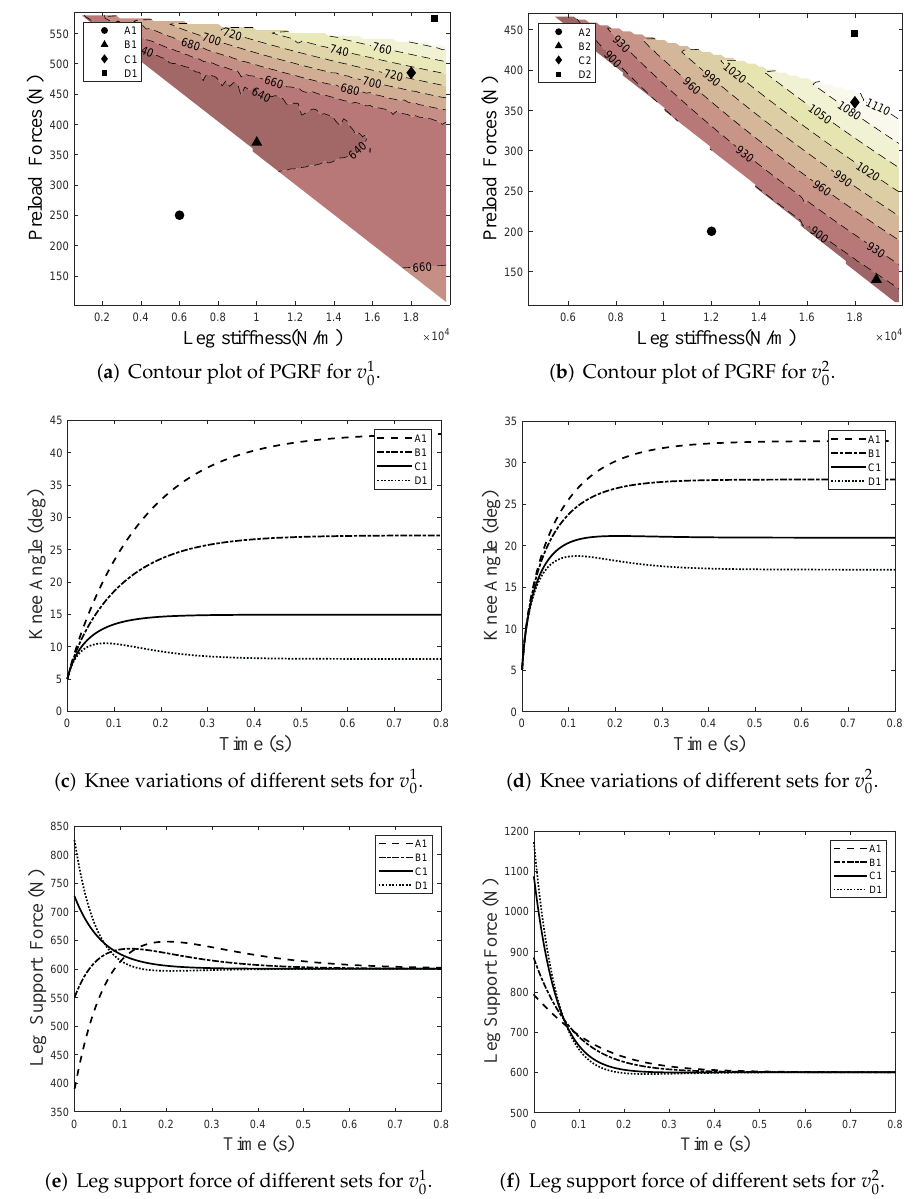
( e ) Leg support force of different sets for v 1 0 . ( f ) Leg support force of different sets for v 2 0 . Figure 7. Simulation results for v 1